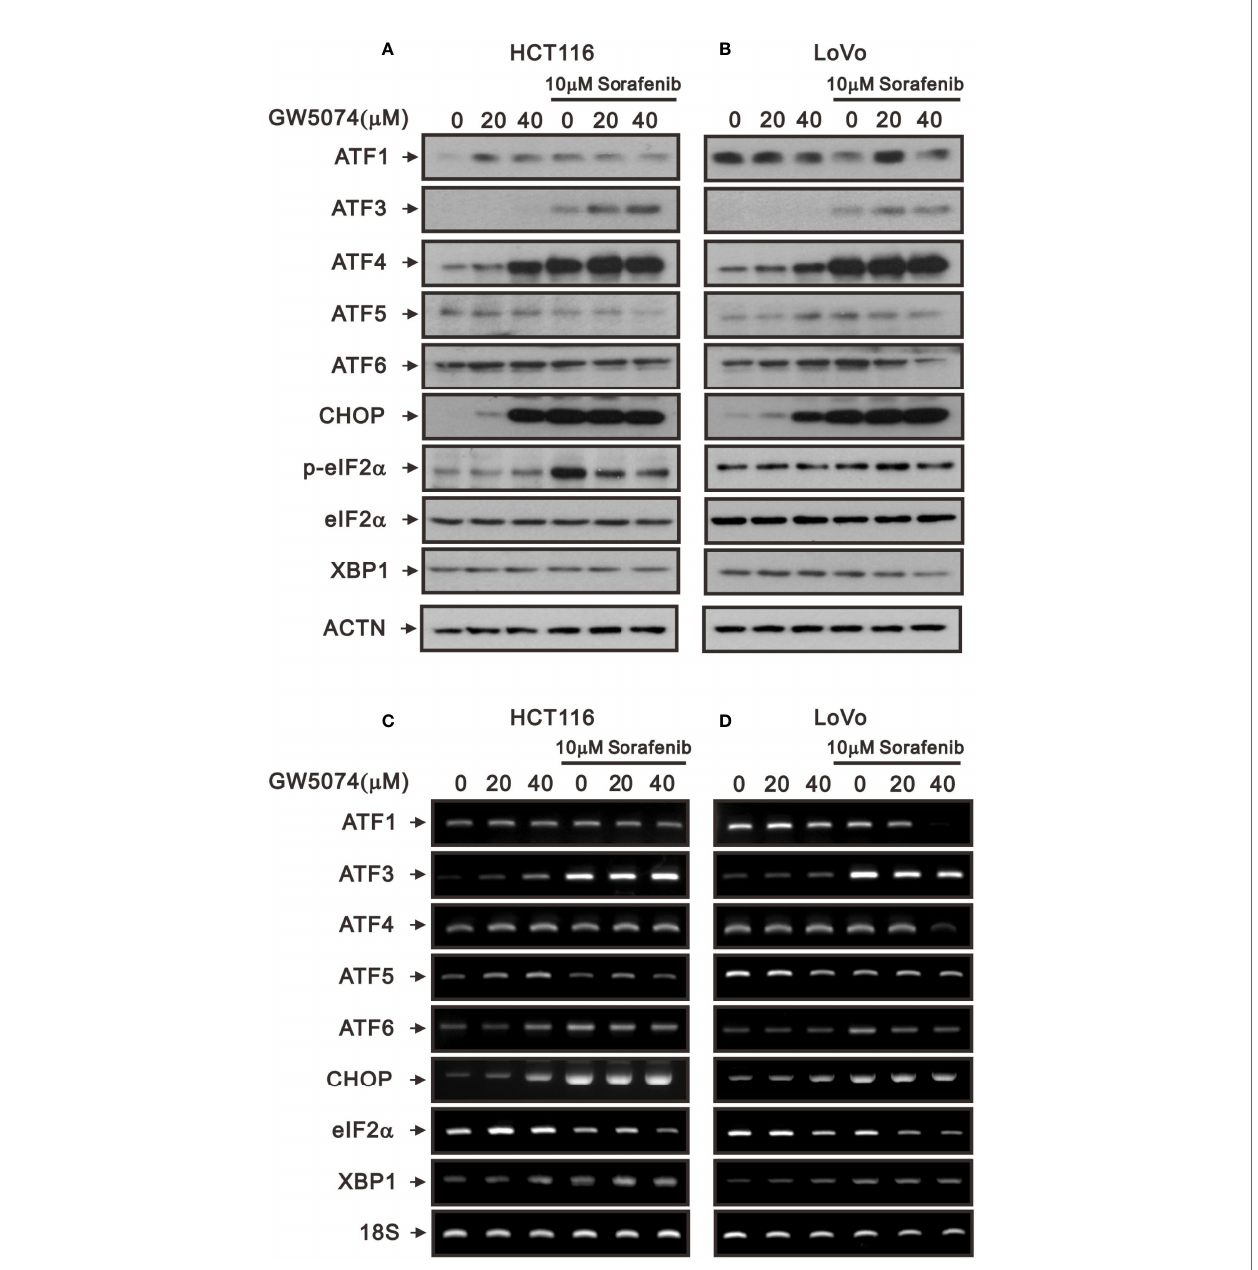
FIGURE 6 | The effects of GW5074 and sorafenib on ER stress of HCT116 and LoVo cells. HCT116 and LoVo cells were treated with 0, 20, and 4 µM GW5074 in the absence or presence of 10 µM sorafenib for 24 h. (A, B) Cell lysates were subjected to Western blotting analysis. ACTN is a loading control protein. (C, D) Total RNA were subjected to RT-PCR analysis. 18S is a loading